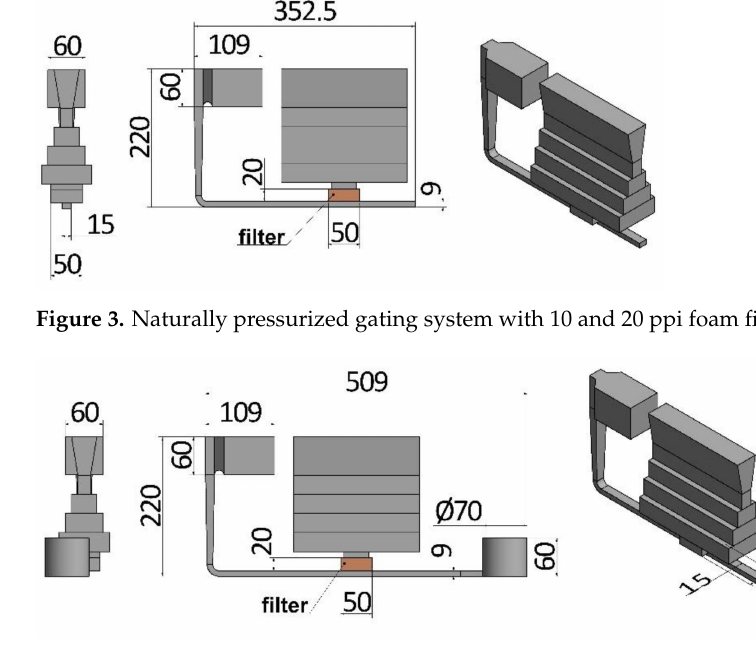
Figure 4. Naturally pressurized gating system with 20 ppi foam filter and vortex element. Table 1. Chemical composition of aluminium alloy